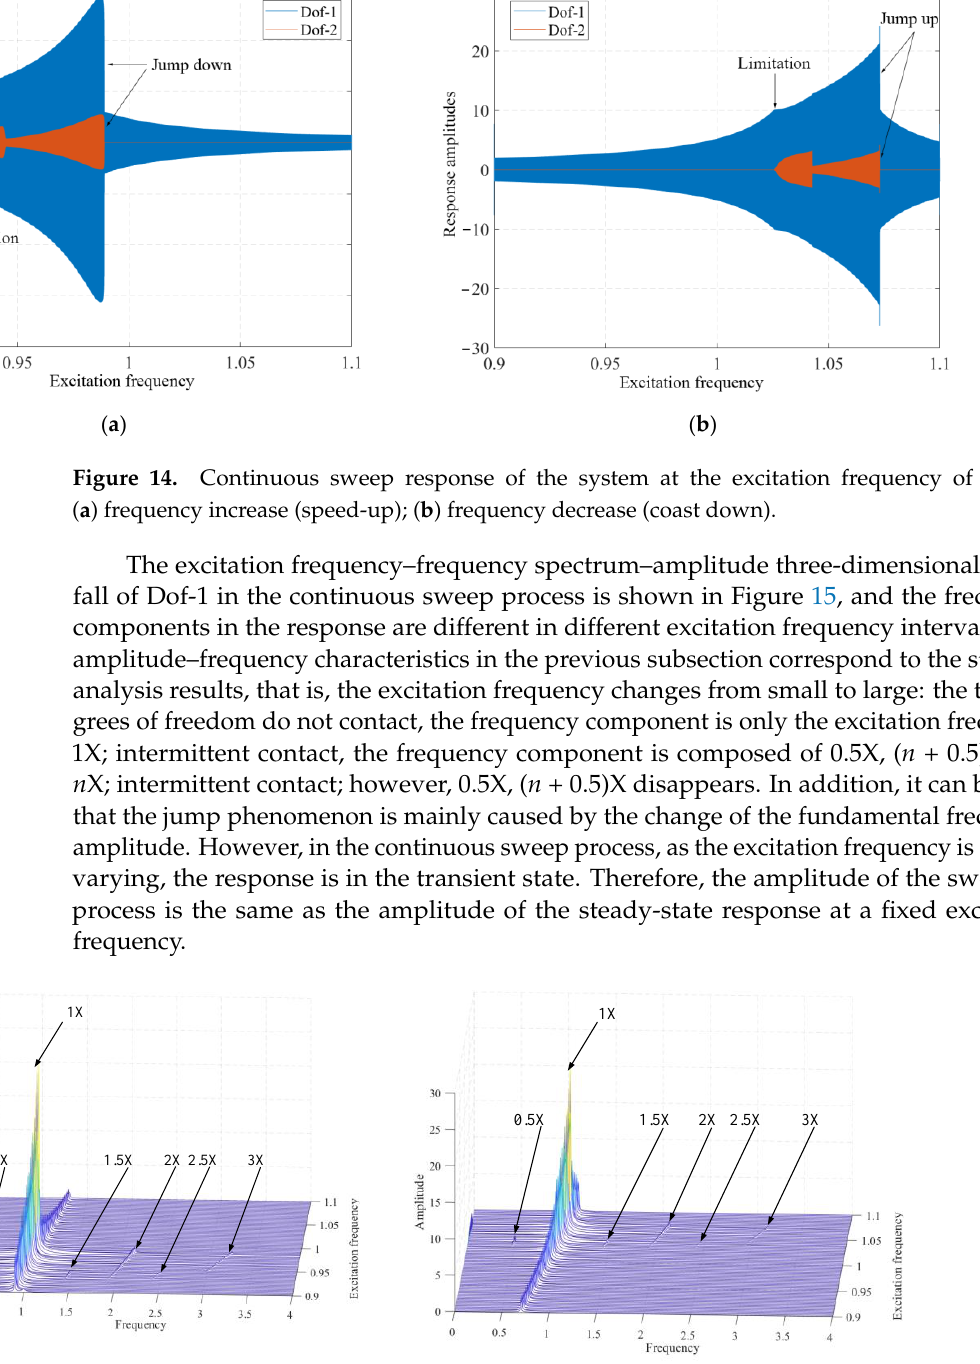
( b ) Figure 13. Characteristics of the attraction domain distribution of the two steady-state solutions at an excitation frequency of 1.06: ( a ) overall scope; ( b ) local scope. 3.3. Sweep Frequency Response The sweep method can simulate the jump phenomenon in the process of excitation frequency increase and decrease. The Ode15s solver in Matlab is used, and the continuous